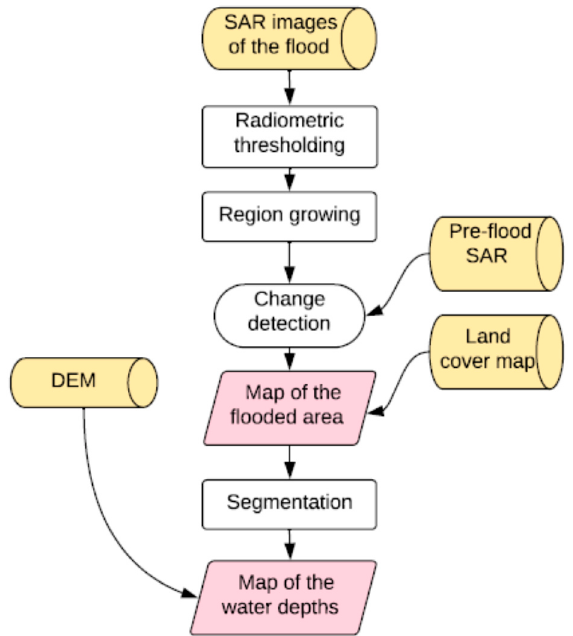
Figure 2. Schematic flow diagram of the proposed methodological framework.